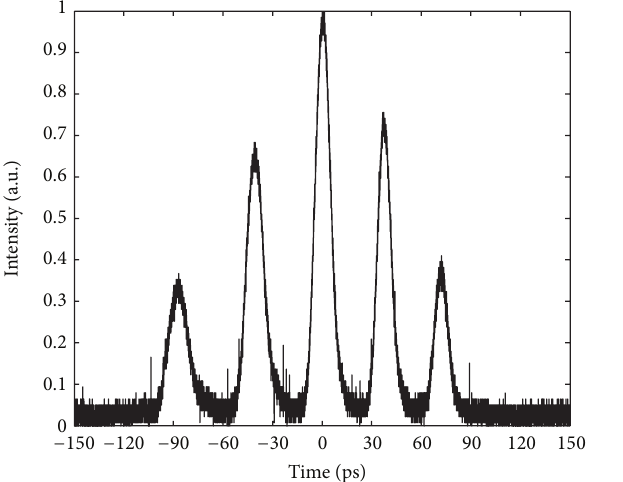
Figure 6: Autocorrelation trace of the bound state of three dissipa- tive solitons.